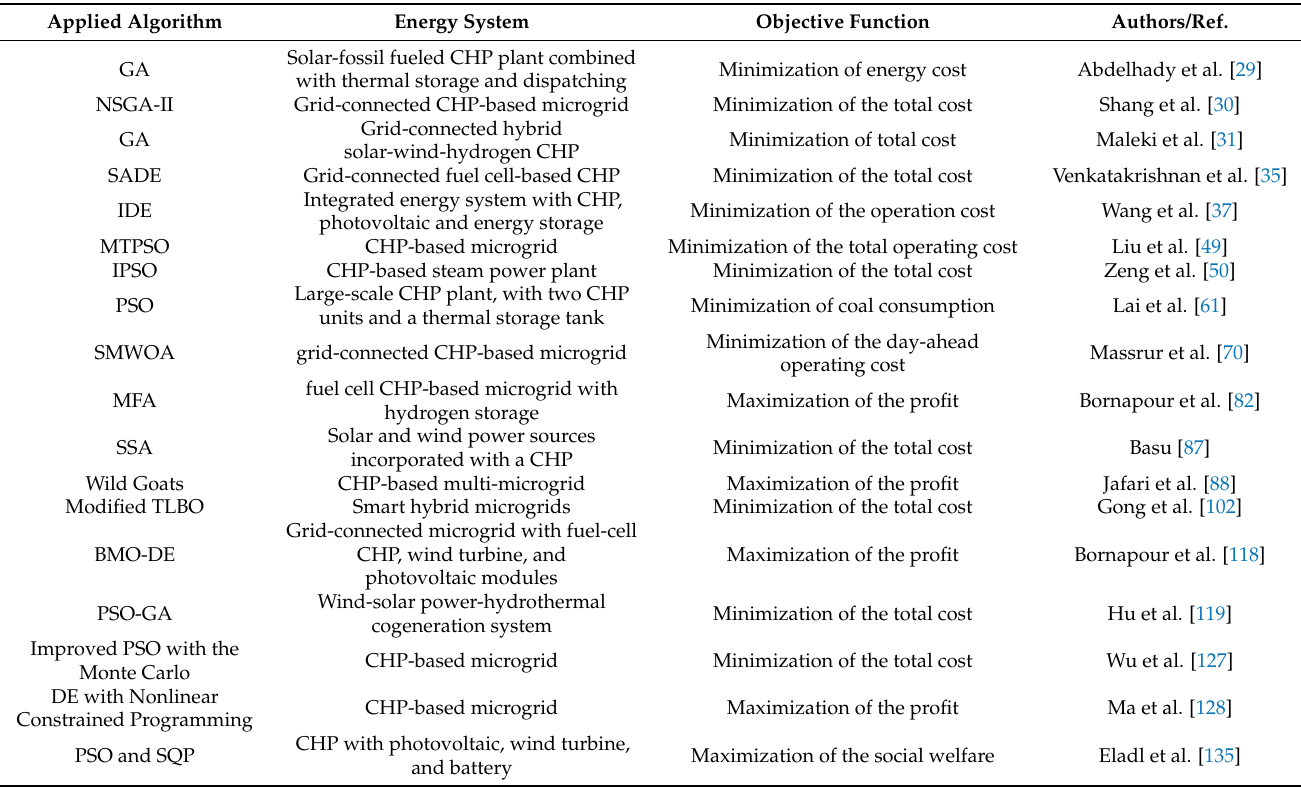
Table 2. Single-objective scheduling issues of CHP energy